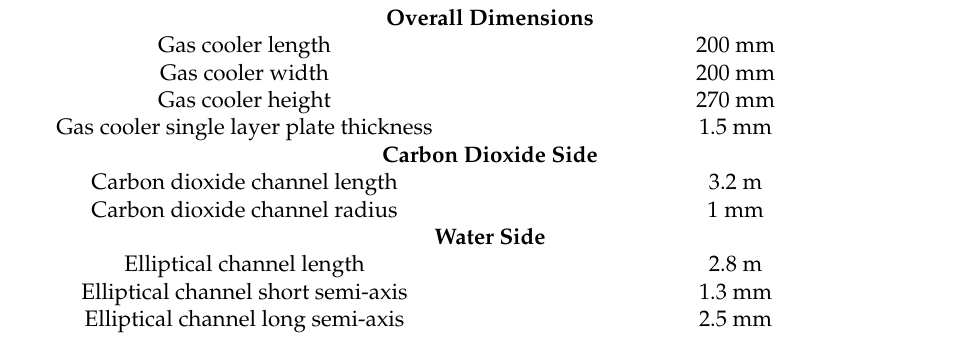
Table 1. Important dimensions of the gas cooler.